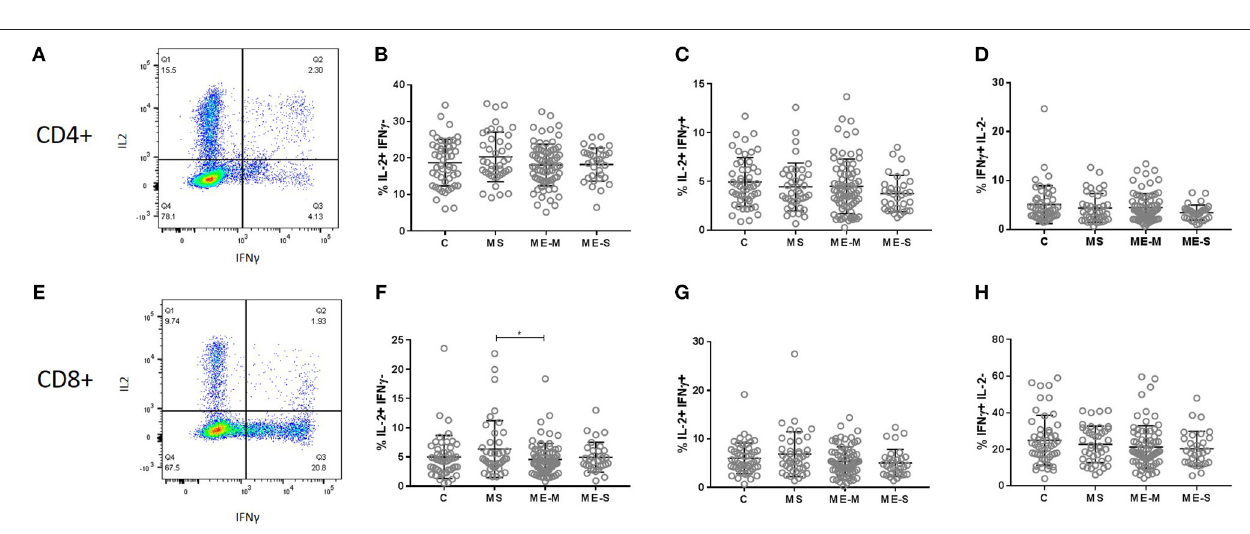
FIGURE 8 | Production of cytokines by T cells in response to stimulation in vitro . PBMC from mild/moderately affected ME/CFS (ME-M: n = 76), severely affected ME/CFS (ME-S: n = 32) or multiple sclerosis (MS: n = 41) patients or healthy control (C: n = 50) individuals were cultured in vitro with PMA and ionomycin for 4h. The production of IFN γ and IL-2 cytokines was assessed in CD4 + (A–D) and CD8 + (E–H) T cells, with the proportions of cells which produced only IL2 (B,F) , both IL2 and IFN γ (C,G) or only IFN γ (D,H) calculated for each study participant. Within the dot plots, the lines show the means and the error bars show ± SD.